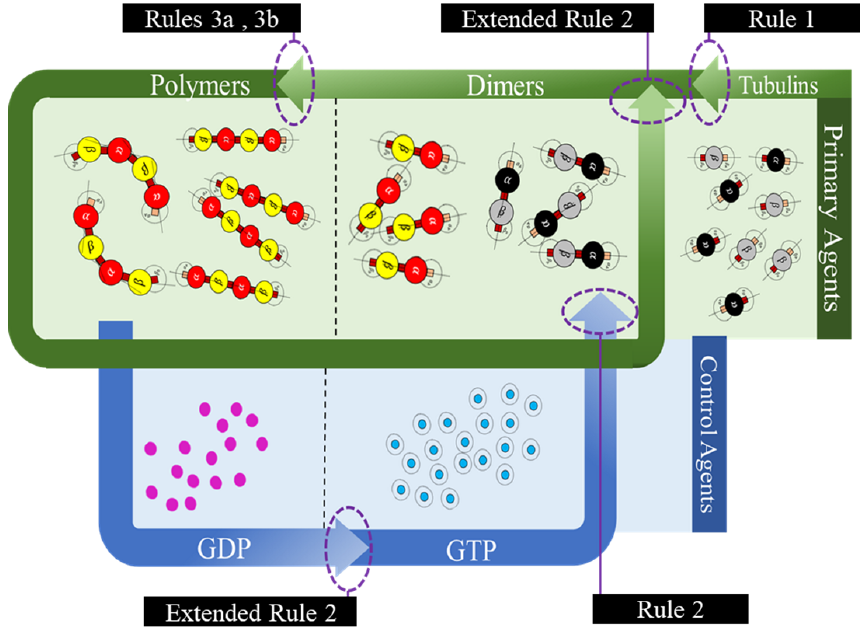
Figure 9. A summary of agent segregation and interaction